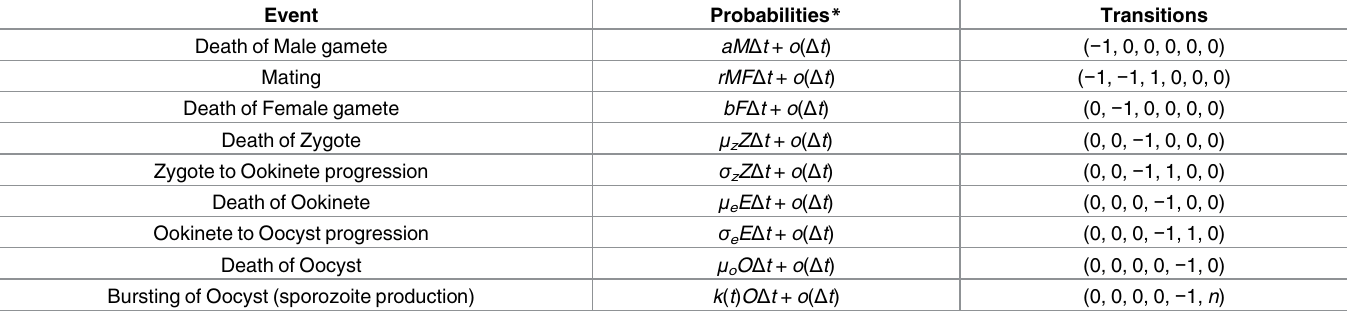
Table 2. CTMC transition probabilities for the stochastic within-vector model. * Note that probabilities are denotedin the standard form used by [40]. For calculation, the term as written is dividedby the sum of all transitions. See SI File for details.